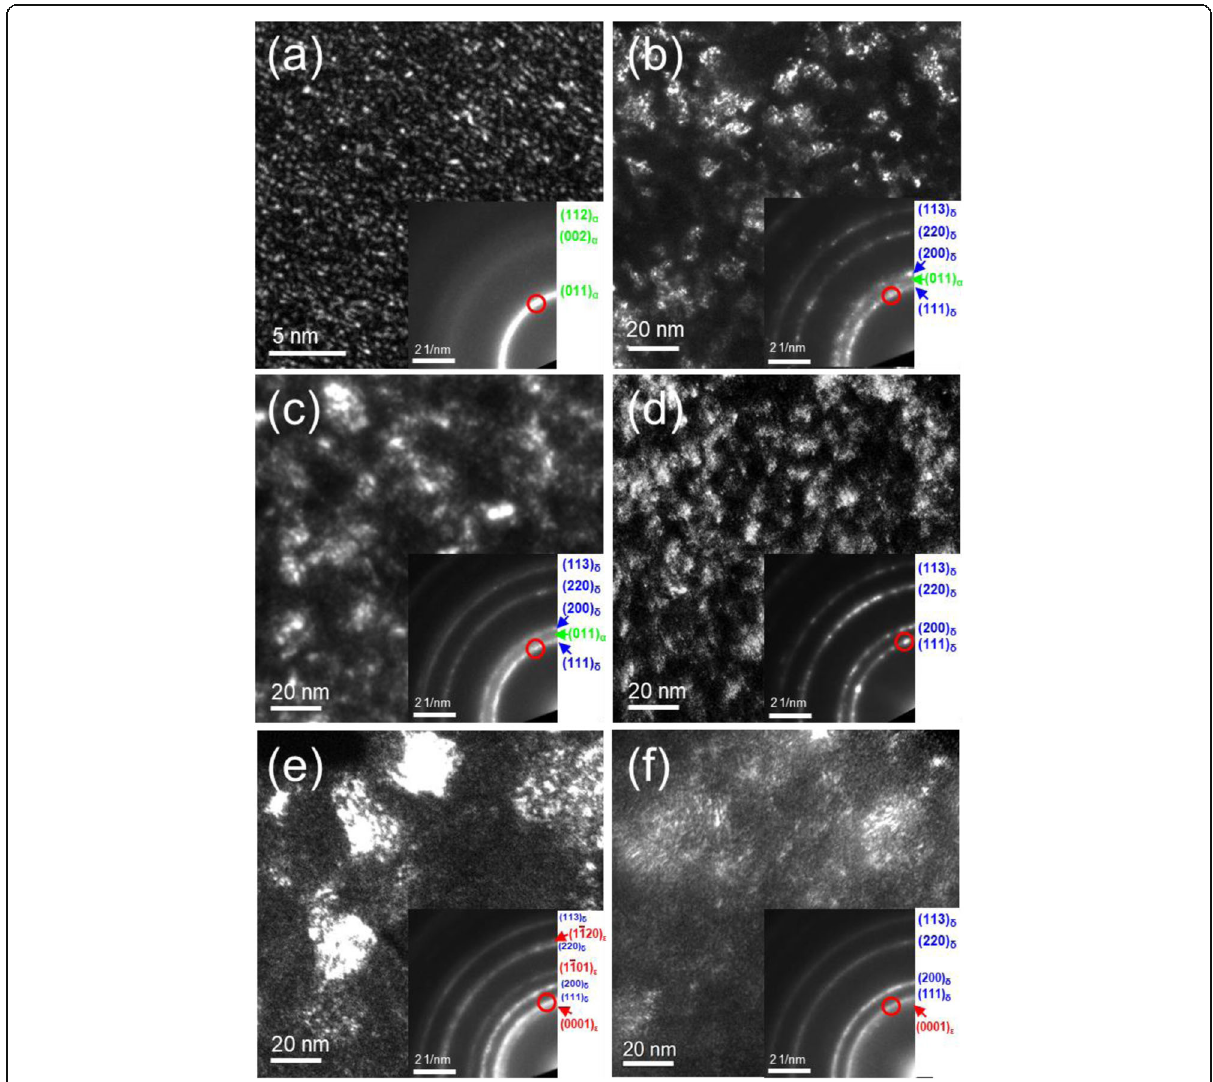
Fig. 3 DF PTEM analyses of the top region of TaN x films grown with different nitrogen gas fractions ( f N2 ) and ICP powers (W). (a, b) 0.05 f N2 at 100 W and 400 W, (c, d) 0.1 f N2 at 100 W and 400 W, (e, f) 0.15% f N2 at 100 W and 400 W. The position of DF reflection is represented by the red circle in the SADP in the inset of each image. The magnification of DF image for 0.05 f N2 at 100 W in (a) is different from others to see the small